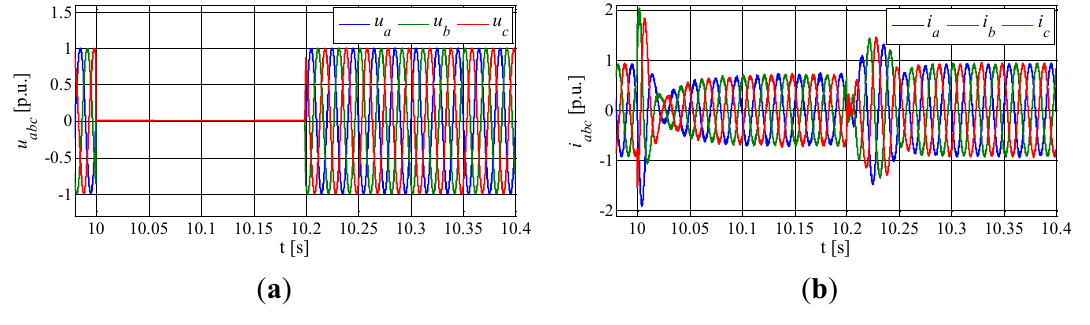
Figure 12. Simulation results under three phase ground fault conditions. ( a ) Unbalanced grid voltage; ( b ) Grid side converter current; ( c ) Active and reactive power transferred to the grid; ( d ) Generator speed; ( e ) Pitch angle; ( f ) Output power of D-PMSG; ( g ) EPT low voltage side DC voltage; and ( h ) Active power absorbed by the super-capacitor stack.